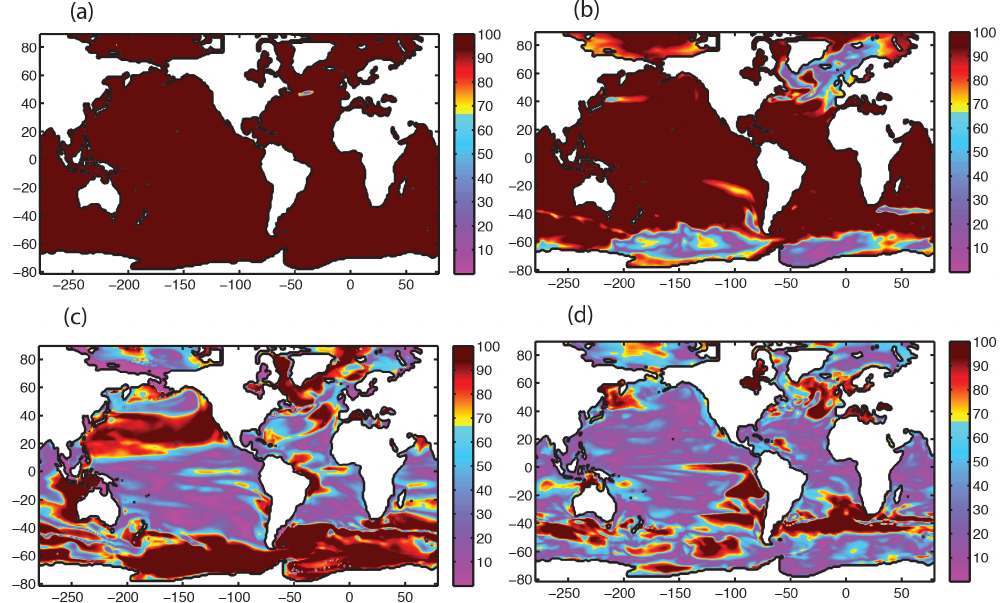
Figure 3. Confidence interval maps averaged over the period 2075–2084 for (a) (cid:127) arag , (b) SST, (c) O 2 inventories, and (d) NPP. For each case, a 30-year window has been used to calculated trends gridpoint by gridpoint for each year between 2005 and 2014. An average over 10 years was considered to remove shorter timescale fluctuations in the signal-to-noise ratio. Note that the color scheme here is chosen such that saturation occurs (maroon color) above the 67% confidence interval. Warm colors indicate confidence intervals ranging from 67–100% (more than one standard deviation), and cool colors span the range 0–67% (less than 1 standard